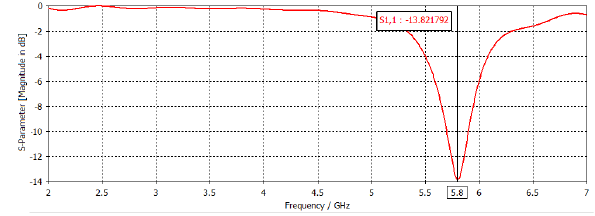
Figure 12. Return loss for Taconic RF 35P.